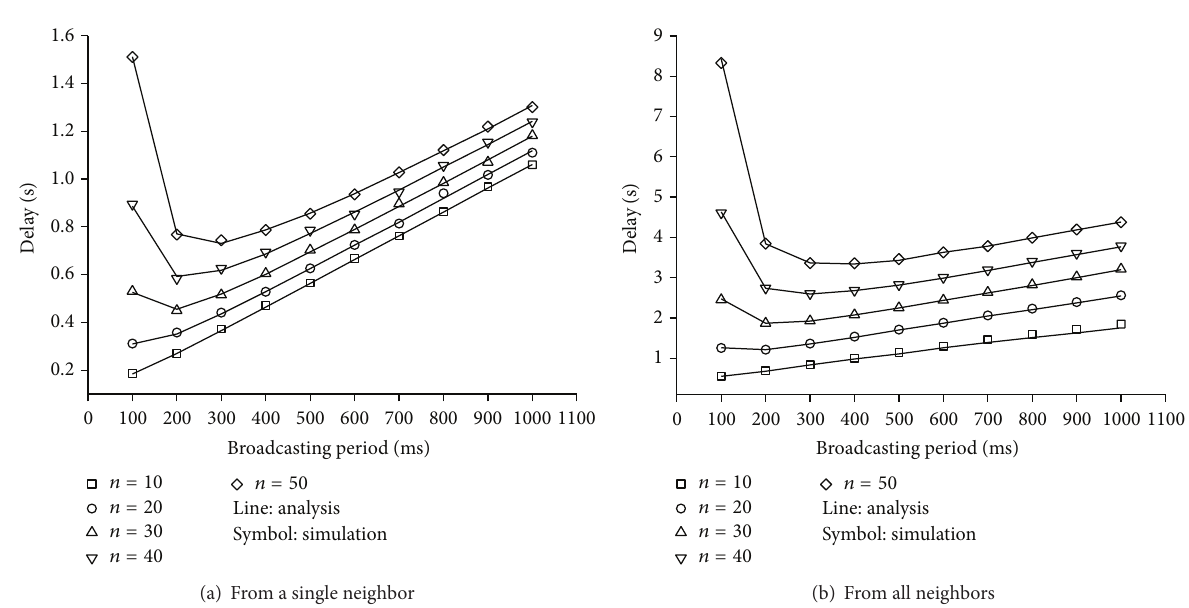
Figure 13: Average delay for a node to successfully receive the NMU message from its